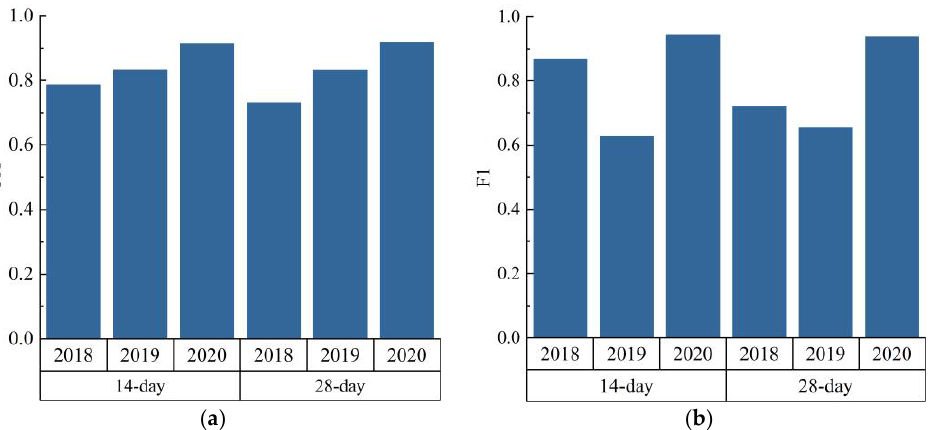
Figure 10. Extraction accuracies based on training samples from 2013 – 2017. ( a ) Overall accuracy; ( b ) F1 scores.